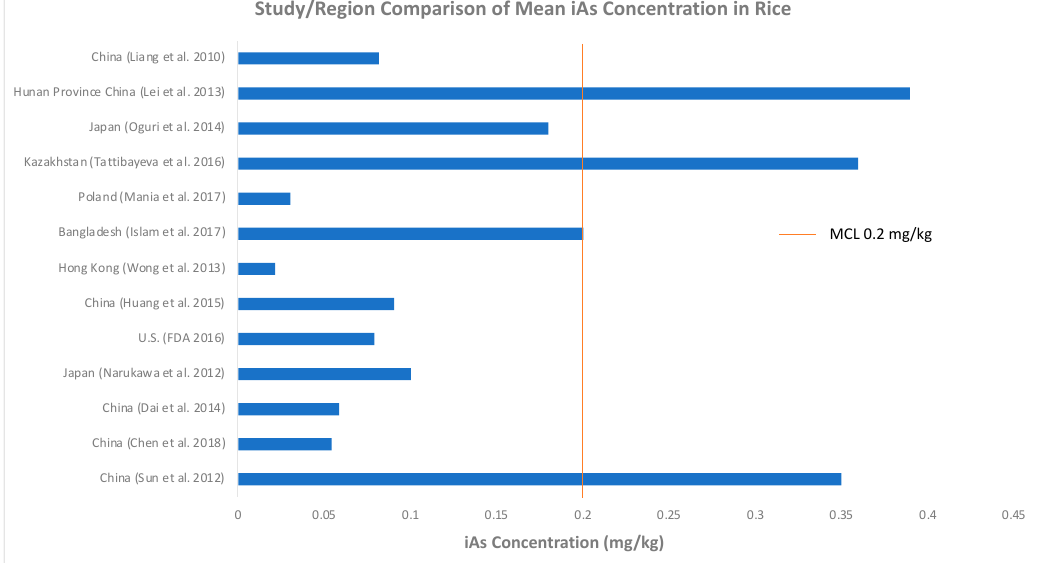
Figure 1. Comparison of LCR values from different studies and regions.